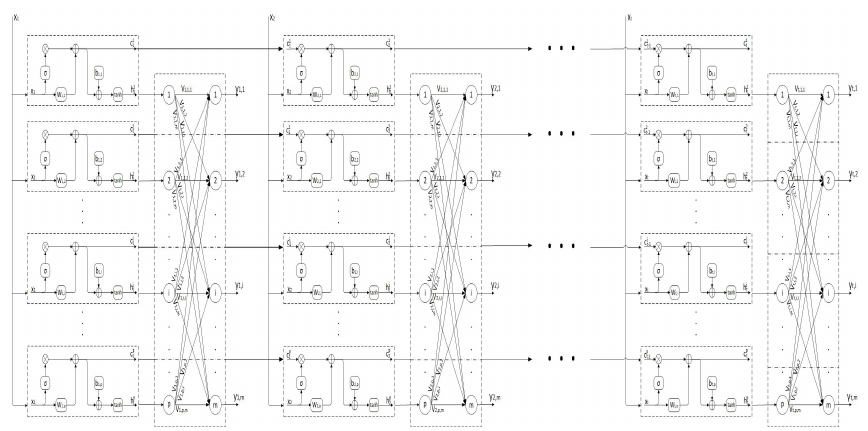
Figure 4. Schematic diagram of the improved